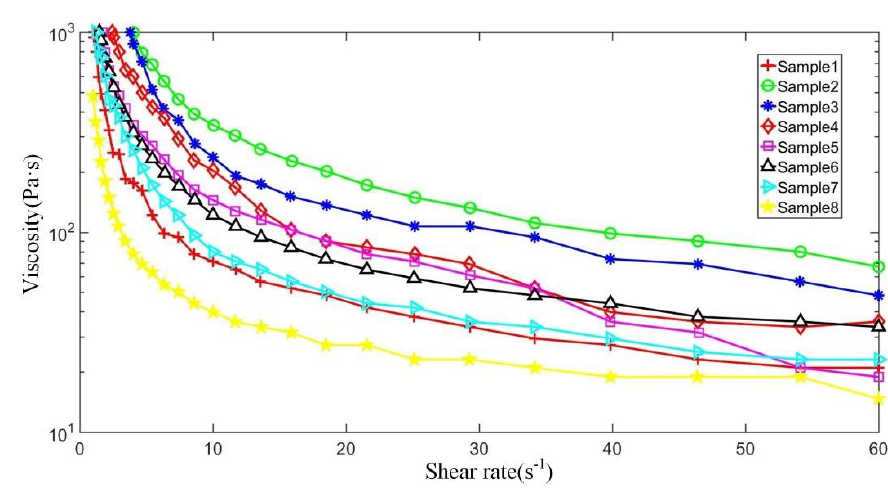
Figure 3. Relationship between off-state viscosity and shear rate.